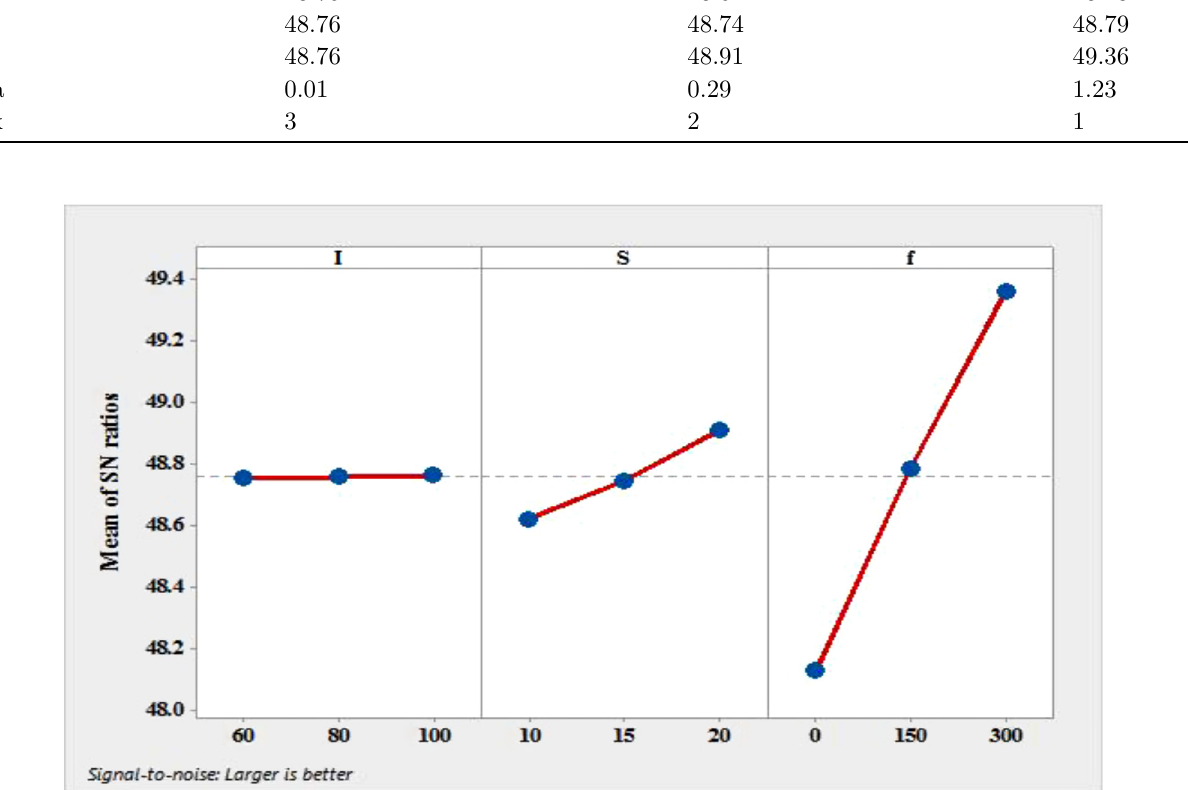
Fig. 3. Main effect plot of S/N ratio of hardness values for L 9